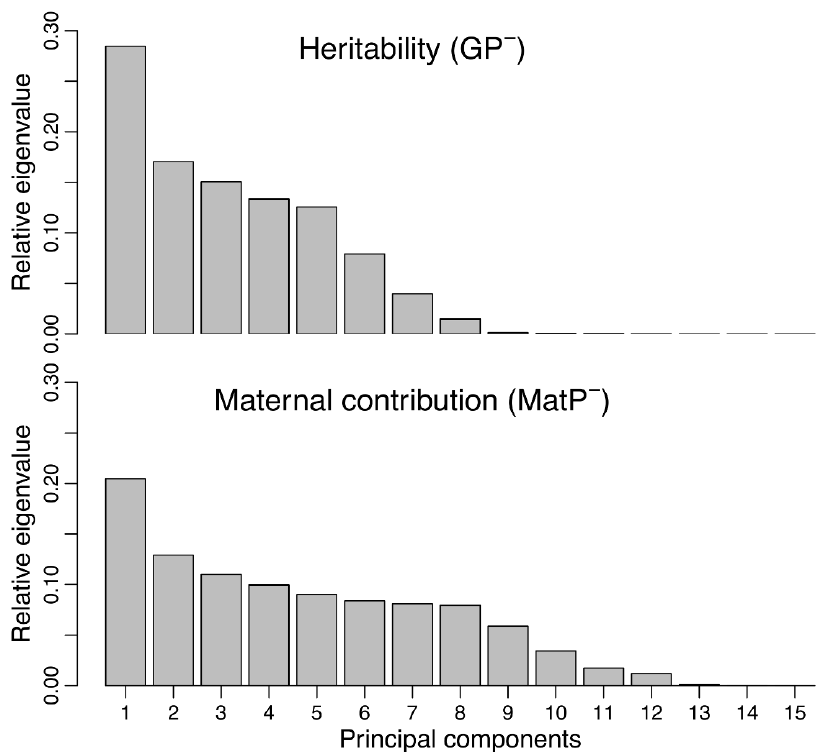
Figure 3. Eigenvalues of the matrices GP − and MatP − , which express the heritability and maternal contributions to the shape variations. The dominant eigenvalue describes the directions of the maximum additive heritability ( h 2 ) and maximum maternal effects, respectively.